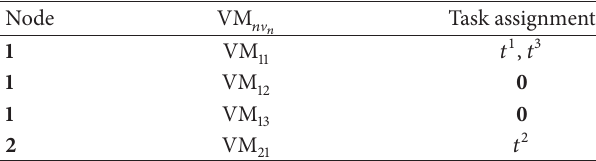
Table 9: Low slowdown. Solver assignment.